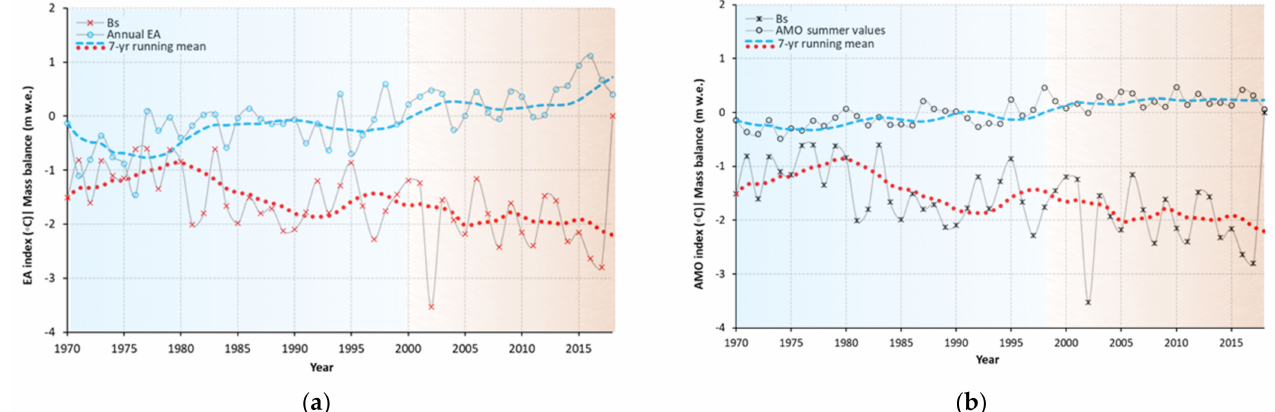
Figure 7. The relationship between the annual East Atlantic (EA) ( a ) and summer Multidecadal Atlantic Ocean (AMO) ( b ) indices versus summer mass balance from 1970 to 2017, with strong negative correlation coefficients of − 0.86 and − 0.88 ( p < 0.05), respectively, for the 38-year